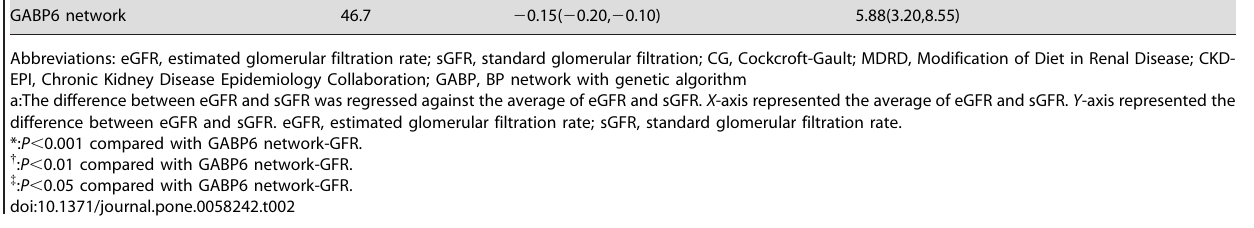
Precision Slope of regression line with (ml/min/1.73 m 2 ) the X-axis a (95% CI)